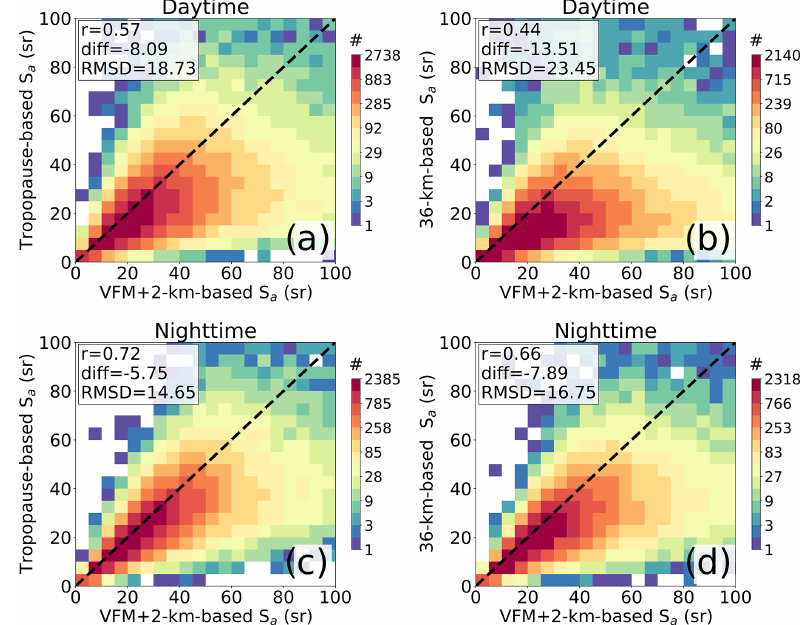
Figure 2. Inter-comparison between CALIPSO–SODA lidar ratio derived from the standard assumption for initial altitude (VFM + 2km, VFM-based) and those estimated using the tropopause height (a, c) and 36km altitude (b, d) . Figures are constructed from 5d of CALIPSO overpasses during July 2010.